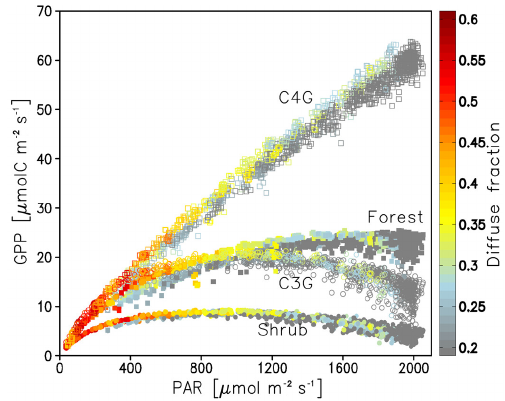
Figure 15. Scatterplots of GPP (µmolCm − 2 s − 1 ) and PAR (µmolm − 2 s − 1 ) from the DIR+DIFF experiment for forest (filled squares) and shrub biomes (filled circles) and grass types C4 (hol- low squares) and C3 (hollow circles) during September 2010 (tem- poral) in the LBAR (spatial). The color scale depicted indicates the fraction of diffuse radiation. The data were filtered for a soil water factor above